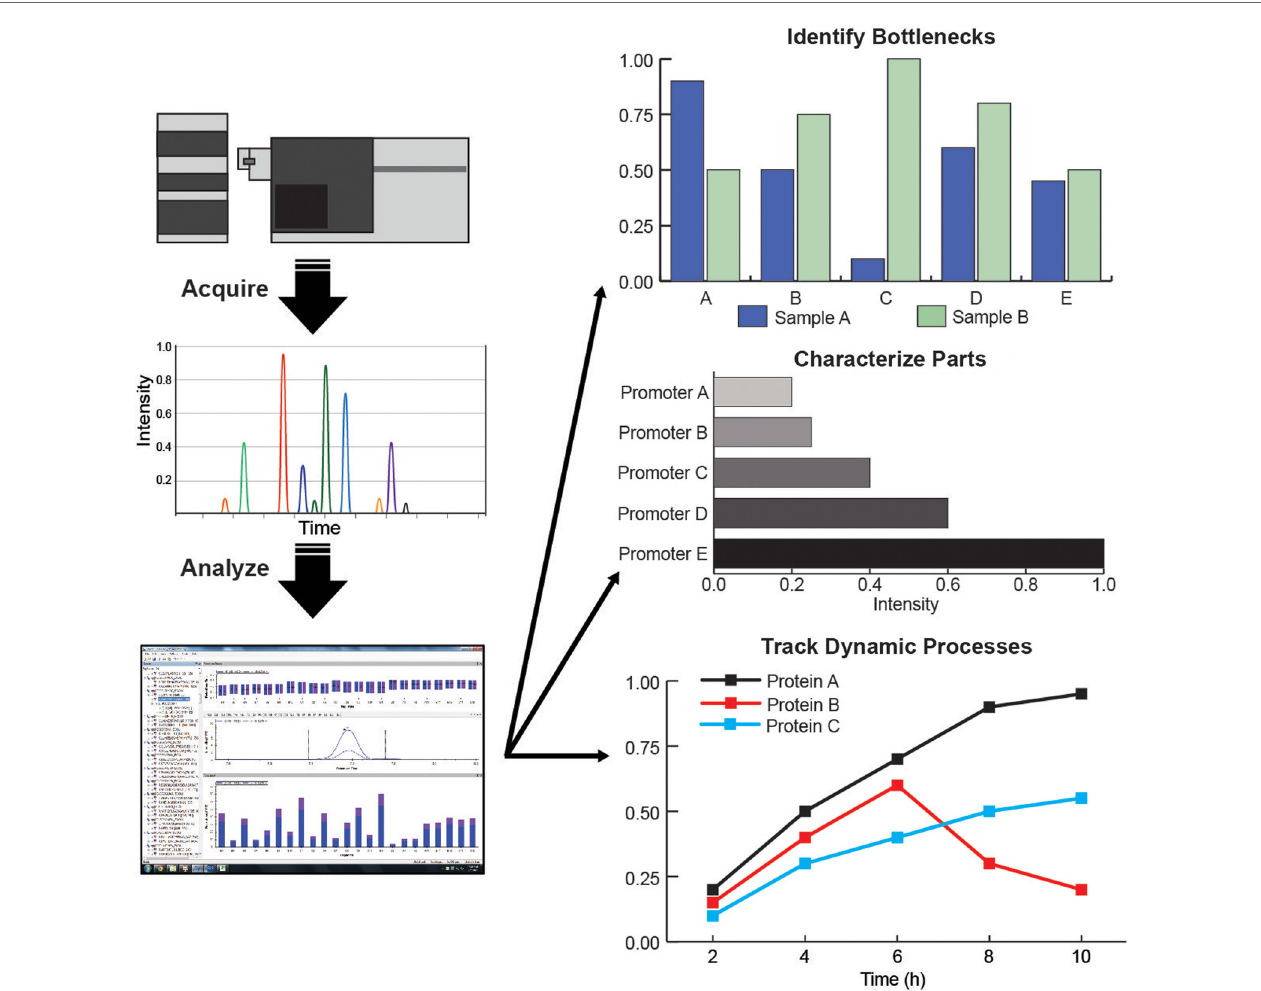
FiGURe 4 | (Left column) Targeted proteomic assay workflows: acquire data from LC/MS, curate data in Skyline, quantify and analyze protein levels and behavior; (Right column) Applications of targeted proteomics for metabolic engineering: identification of pathway bottlenecks, characterization of synthetic biology parts, and tracking dynamic processes